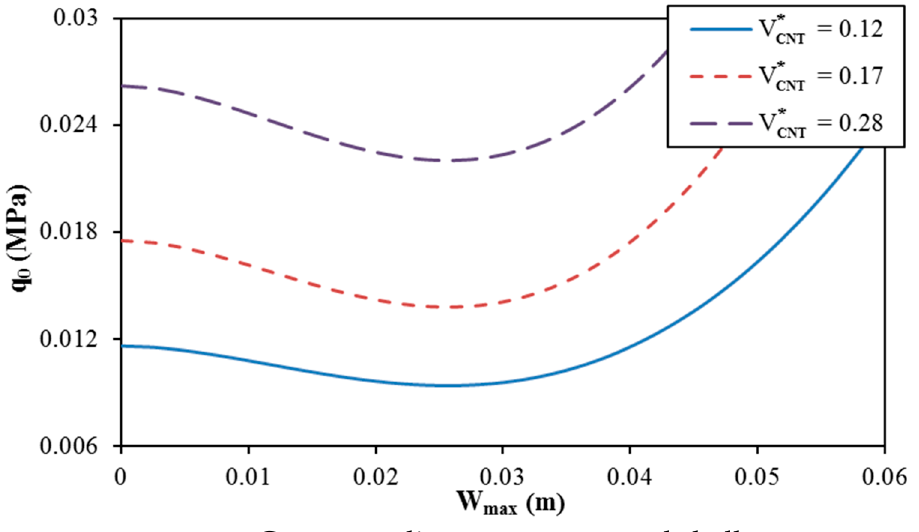
Figure 4. E ff ect of CNT volume fraction V ∗ on the postbuckling curve of ring corrugated UD-CNTRC cylindrical shells and corresponding non-corrugated UD-CNTRC cylindrical shells (trapezoidal corrugation, c = 0.01 m, f = 0.005 m, α = π / 3). A comparison of the postbuckling curve of ring and spiral corrugated UD-CNTRC cylindrical 10 N =